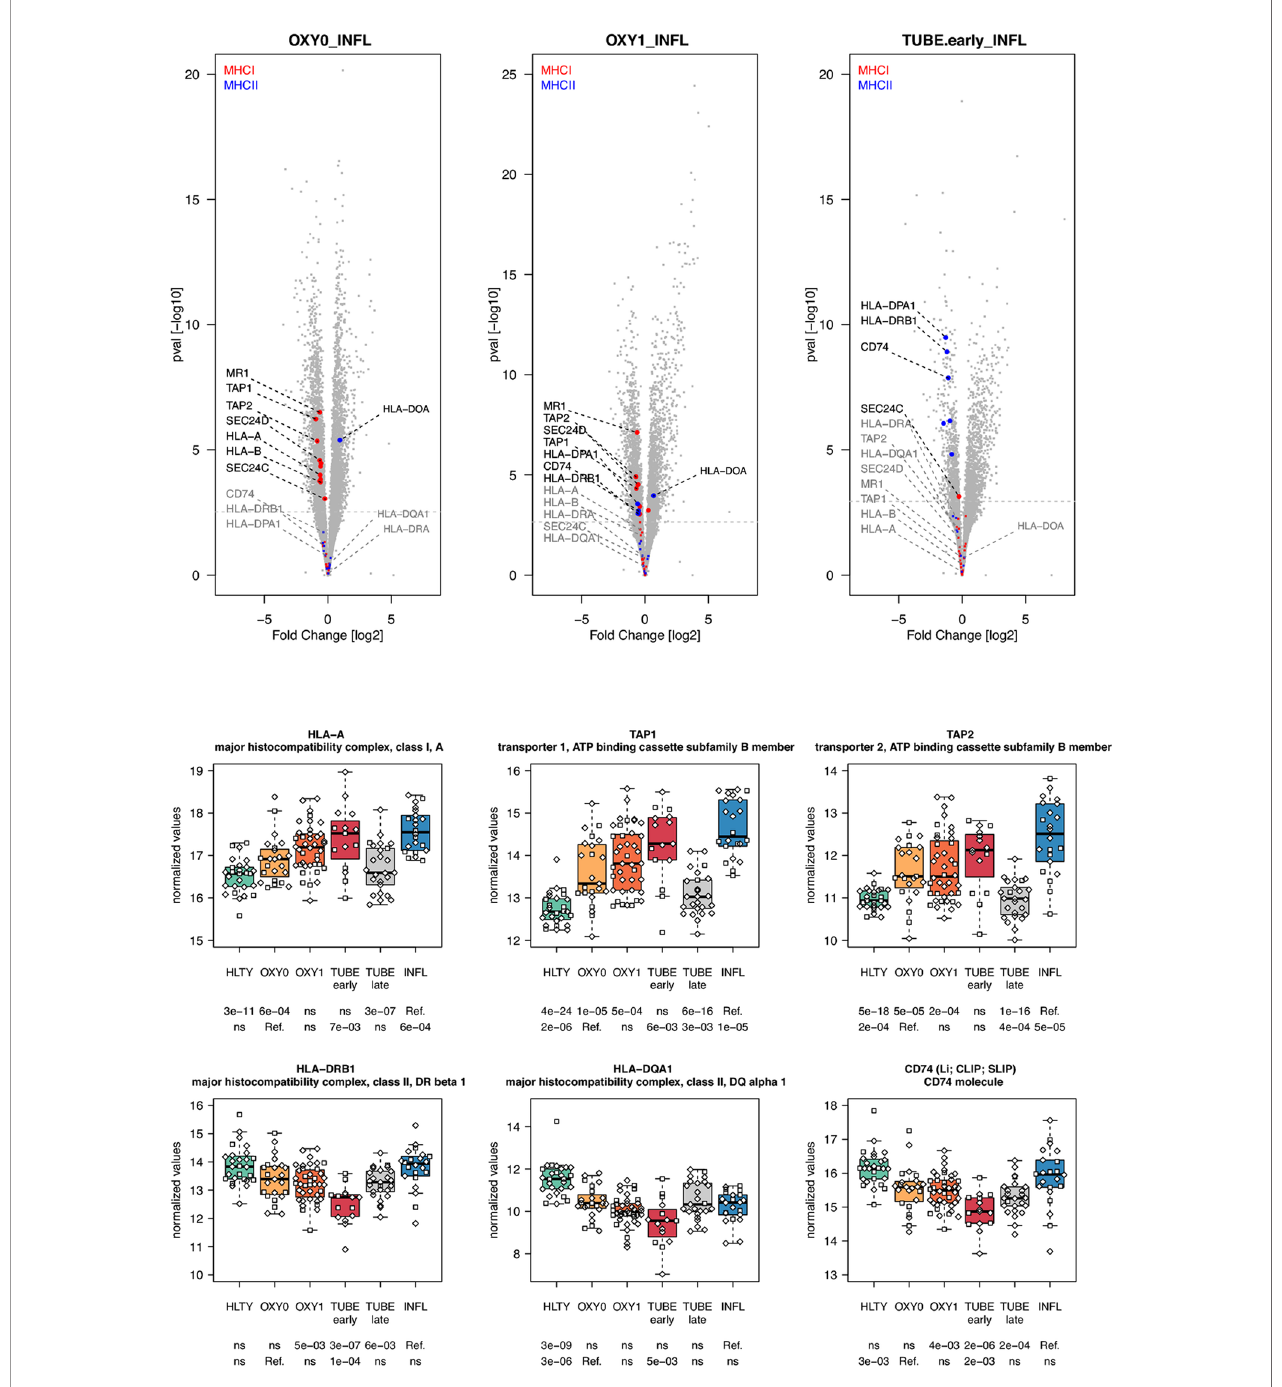
FIGURE 7 | Differentially expressed genes (DEGs) involved in antigen presentation. Upper panel: for each comparison indicated in the volcano plot header, the distribution of log2 fold changes and P-values of all detected genes is shown as gray dots. Red and blue dots indicate genes involved in antigen presentation through the MHC I and MHCII respectively. Genes ’ sets are selected from different GO, REACTOME and/or KEGG pathways (see Supplementary Table 2 ). The dotted horizontal gray line indicates the limit under which – log10(P-value) becomes non signi fi cant once adjusted for multiple testing (adjusted P > 0.01). Lower panel shows detailed expression levels of selected genes involved in antigen presentation through the MHCI and MHC II in the different groups of patients. Groups used for comparisons include SARS-Cov-2 infected patients (no oxygen support [OXY0], oxygen support [OXY1], intubation with sampling within 7 days [TUBE early] or >7 days [TUBE late] after hospital admission), In fl uenza virus [INFL] infected patients and non-infected controls [HLTY]. Adjusted P-values of pairwise comparisons between a reference group (Ref.) and another group are indicated below the x axis. Ref. is taken as [INFL] and [OXY0] on the fi rst and second line,